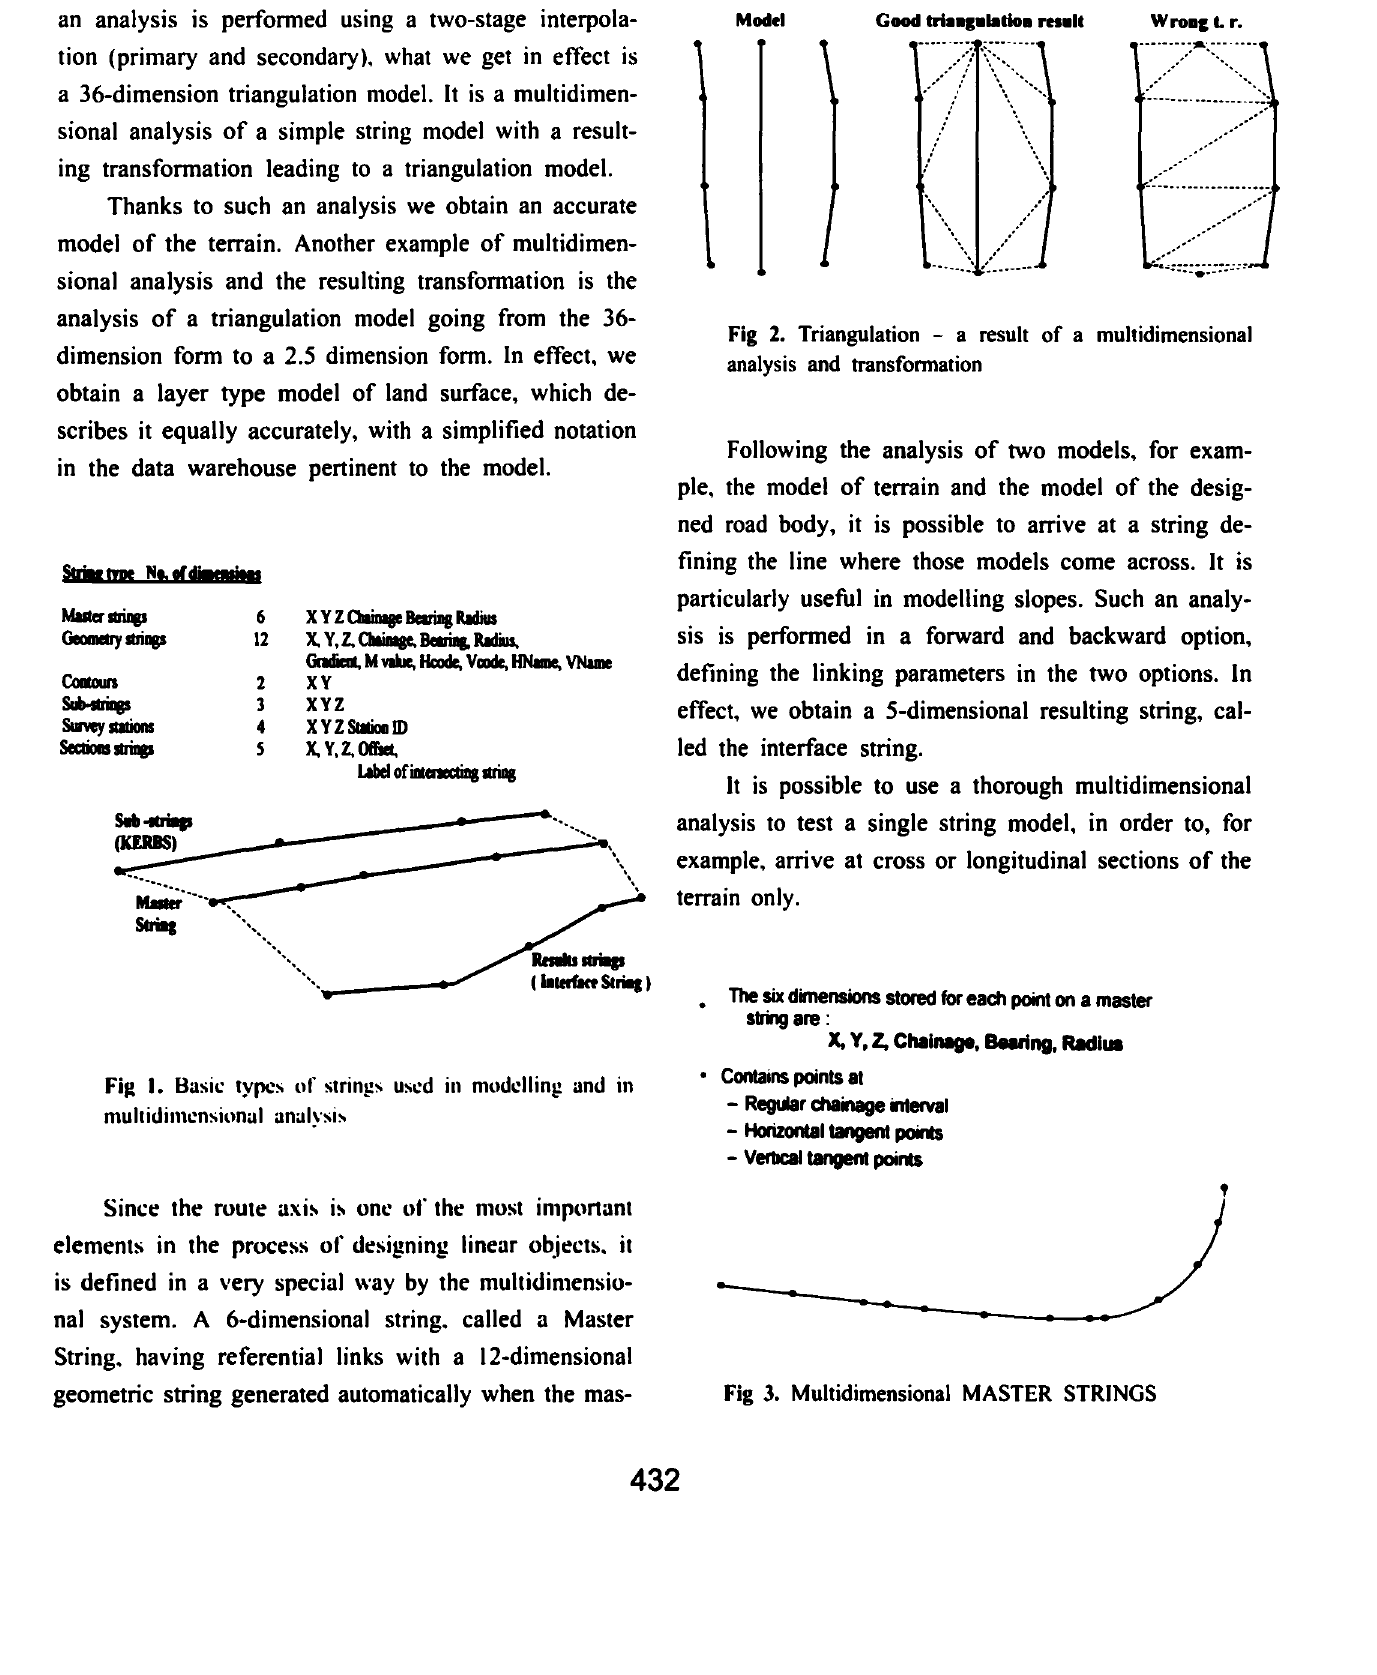
Fig 3. Multidimensional MASTER